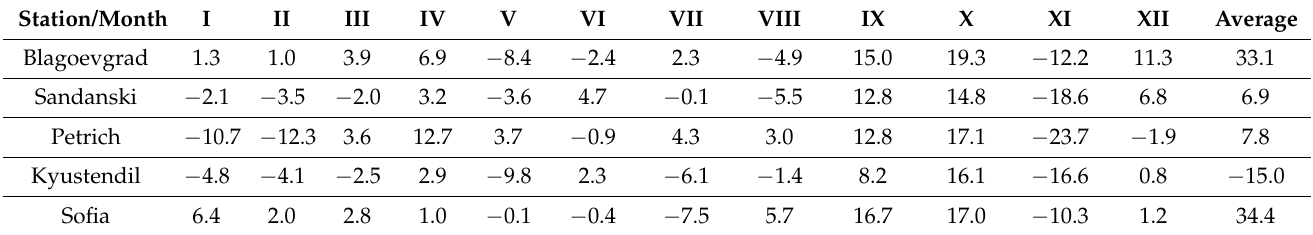
Table 11. Average monthly sums of rainfall deviations in southwestern Bulgaria in the period 1986–2015.